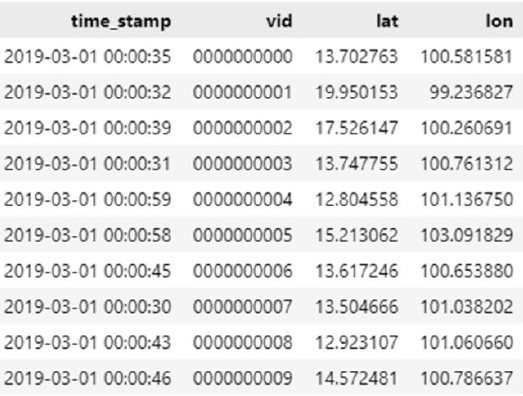
Figure 2. Examples of GPS data of vehicles with data fields that include a date time (timestamp), a masked identifier for each vehicle (vid), a latitude (lat), and a longitude (lon).